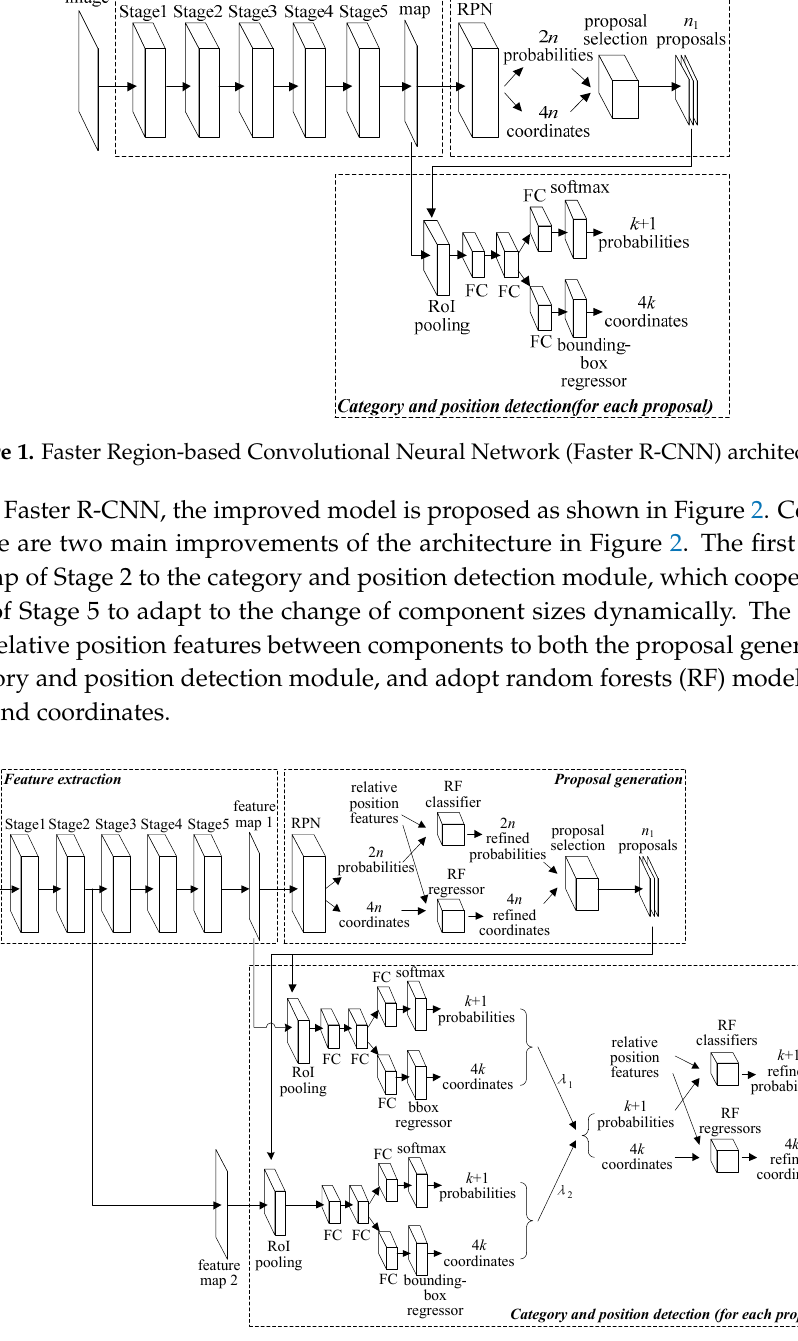
Figure 2. Improved Faster R ‐ CNN architecture.